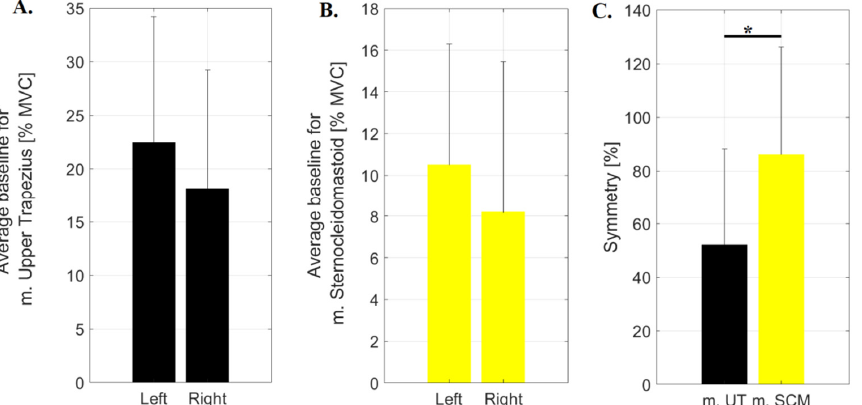
Figure 5. The values of the average activity recorded for the baseline normalized to the MVC for ( A )—upper trapezius muscle; ( B )—sternocleidomastoid muscle and ( C )—values of symmetry index calculated for upper trapezius (m. UT) and sternocleidomastoid (m. SCM); * p ≤ 0.05. Table 2. Statistically significant differences for t -test ( T ) and Wilcoxon’s ( W ) test for dependent groups in mean muscle activity, p <